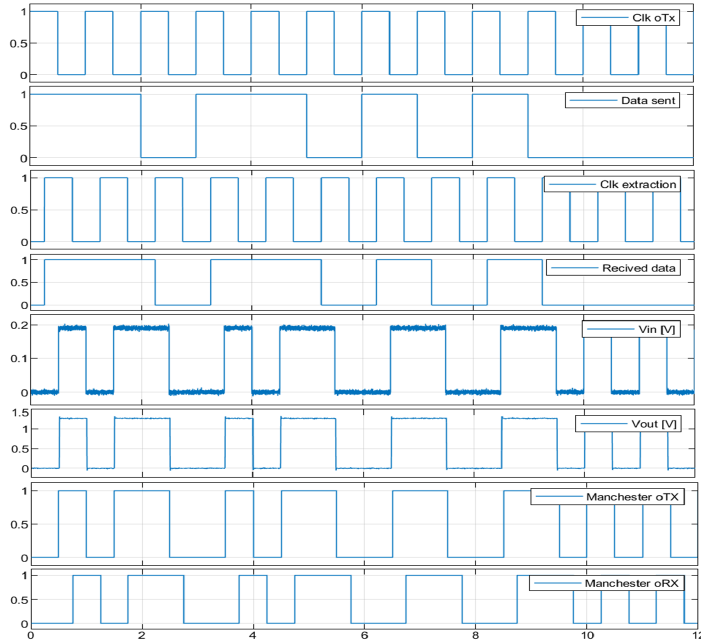
Figure 23. The VLC system simulation results.